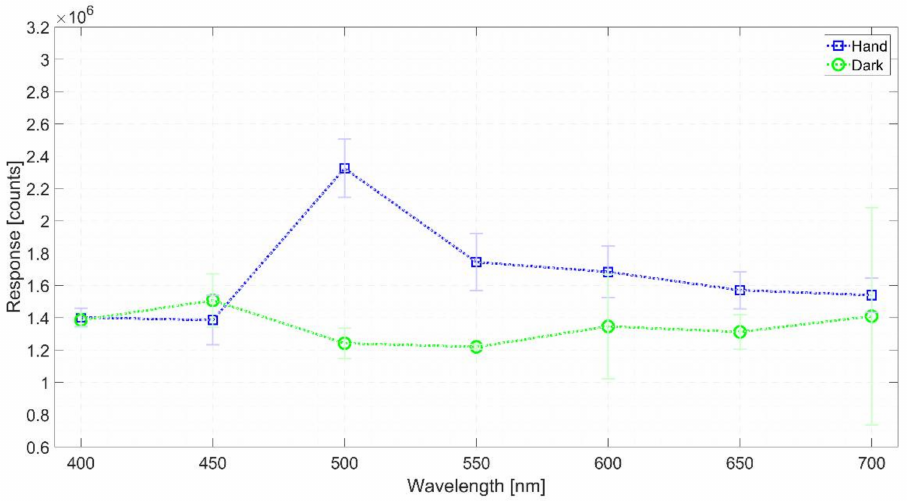
Figure 3. Filtered count vectors depicting the total counts from all the 10-min FVB